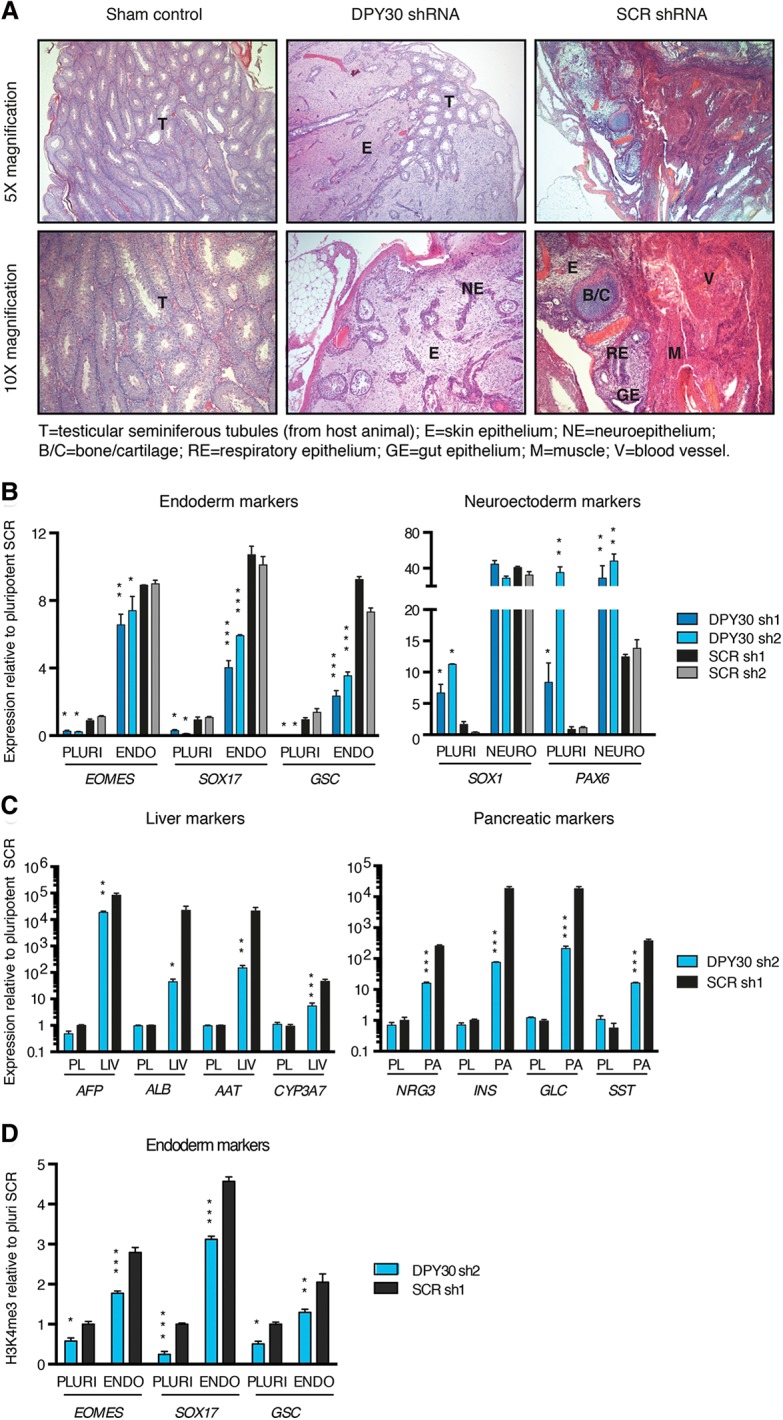
DPY30 is required for mesendoderm differentiation of hESCs. (A) Hematoxylin and eosin histological staining of normal testis tissue (sham control) or teratomas derived from DPY30 knockdown (KD) or control hESCs. (B) Gene expression qPCR in DPY30 knockdown or control hESCs (cells expressing a SCR shRNA) before (PLURI) or after in vitro directed differentiation toward endoderm or neuroectoderm. For each gene, significant differences versus both SCR sh1 and SCR sh2 in the same condition (only the highest P-value is shown) as calculated by two-way ANOVA are reported. (C) Gene expression qPCR as in A but either before (pluripotent [PL]) or after liver (LIV) or pancreas (PA) differentiation. For each gene, significant differences versus SCR in the same condition as calculated by two-way ANOVA are reported. (D) ChIP-qPCR for H3K4me3 in DPY30 knockdown or control hESCs before (PLURI) or after endoderm differentiation. Significant differences versus SCR sh1 in the same condition as calculated by two-way ANOVA are reported.